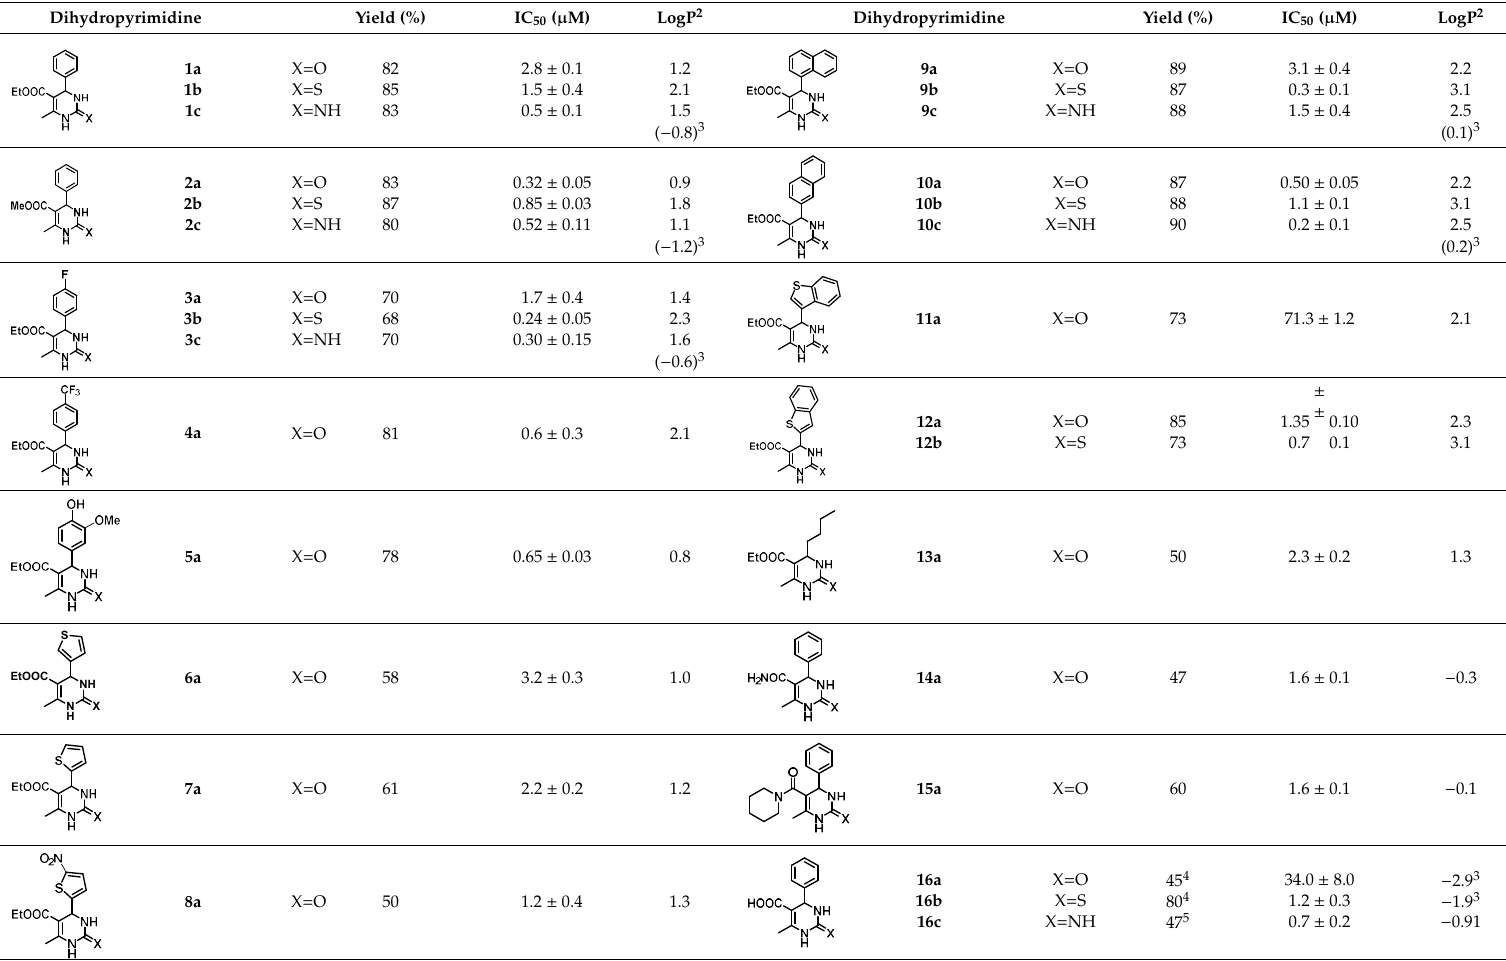
Table 1. Synthesis 1 and BACE-1 inhibitory activity of DHPMs and their thia and imino derivatives obtained as in Scheme 1. Dihydropyrimidine Yield (%) IC 50 ( µ M) LogP 2